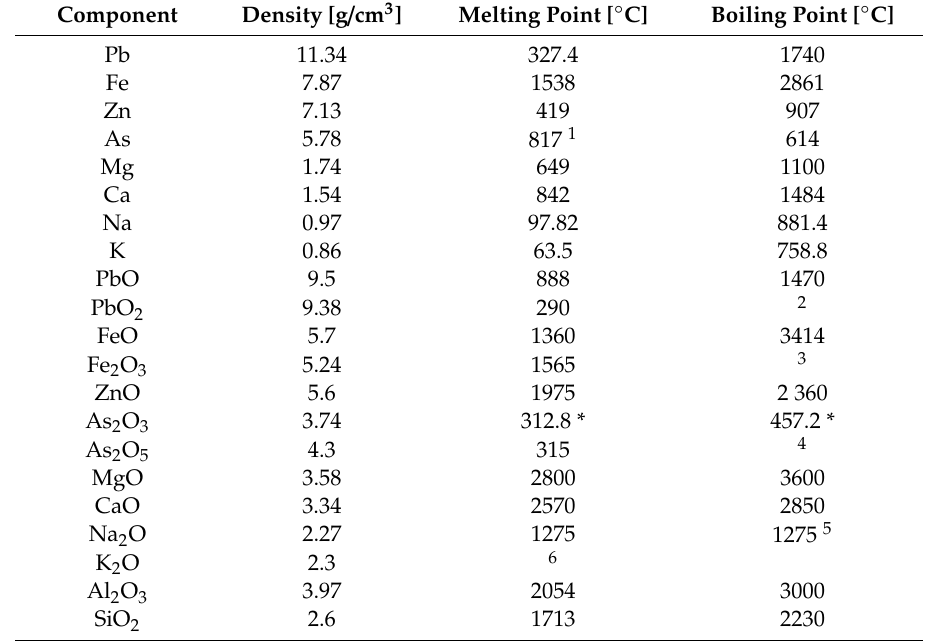
Table 6. Density and melting and boiling points of the most common melt / slag components [56] (*-data from